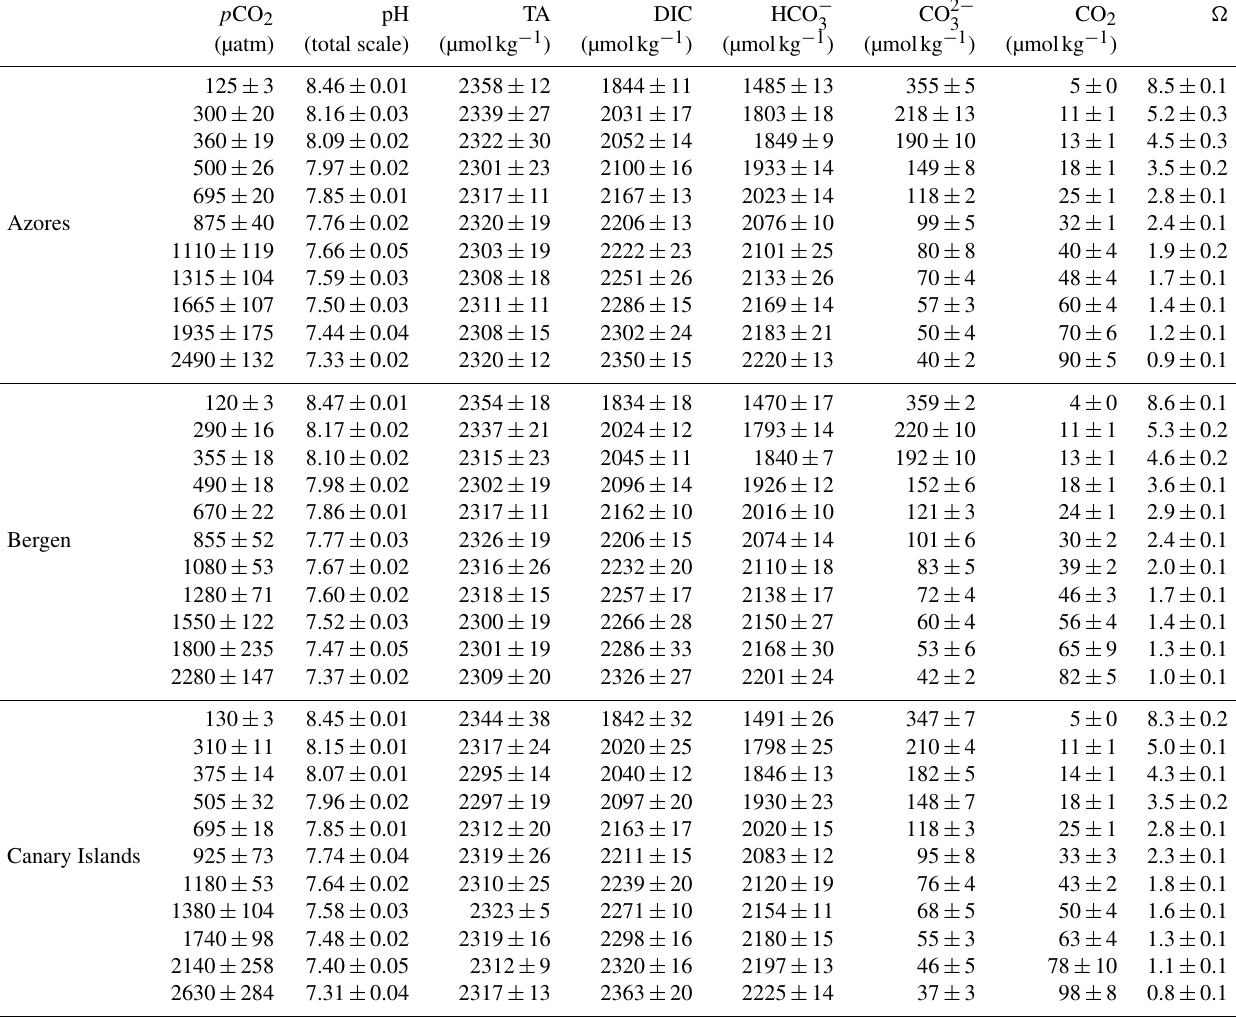
Table 2. Carbonate chemistry parameters (mean values for the beginning and end of the incubations) of the artificial seawater for each Emiliania huxleyi population. The pH and TA samples were collected and measured before and at the end of incubation. Data are expressed as mean values of six strains in the Azores and Bergen population, and five strains in the Canary Islands population. p CO 2 (cid:127)